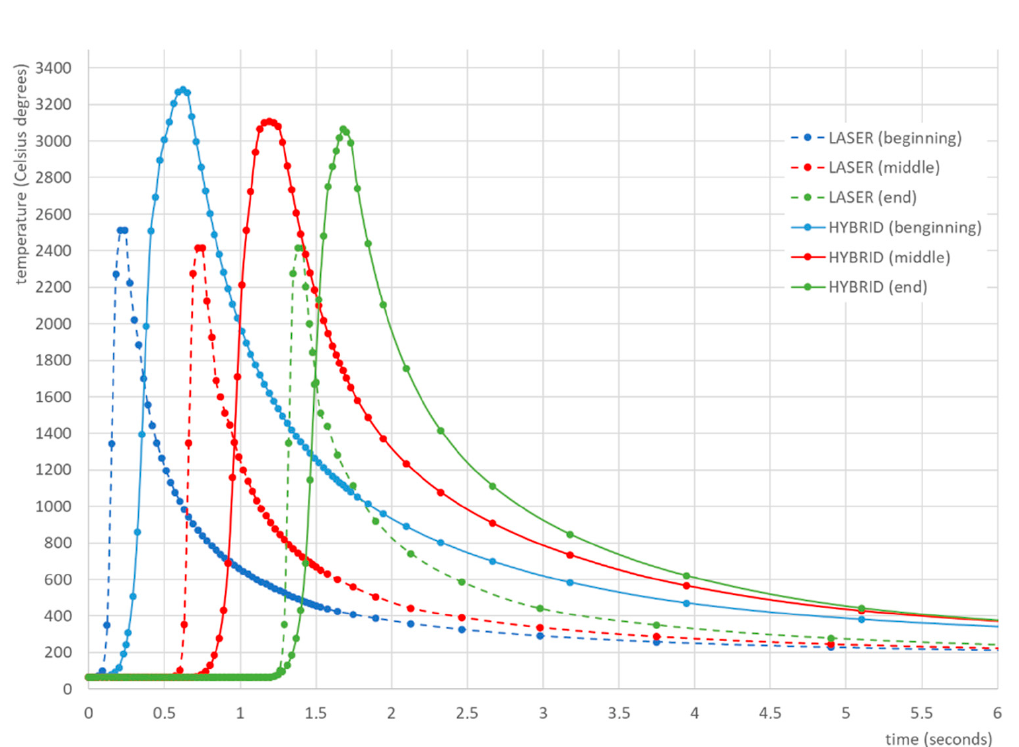
Figure 8. Distribution of calculated Vickers hardness after laser and hybrid welding of S700MC steel T-joints with a thickness of 10 mm (cross-sections were made in the half-length of the joint). The heat cycles calculated in the middle-length of the weld for both analyzed welding methods indicated that the typical t8/5 time (time for the temperature dropping from 800 to 500 °C, inversely proportional to the cooling rate) for laser welding was about 0.65–0.7 s. For comparison, the same time for hybrid welding was about 1.3–1.5 s. Thermal cycles separated to determine the t8/5 time were taken from the beginning, middle, and end of the weld length (Figure 9).